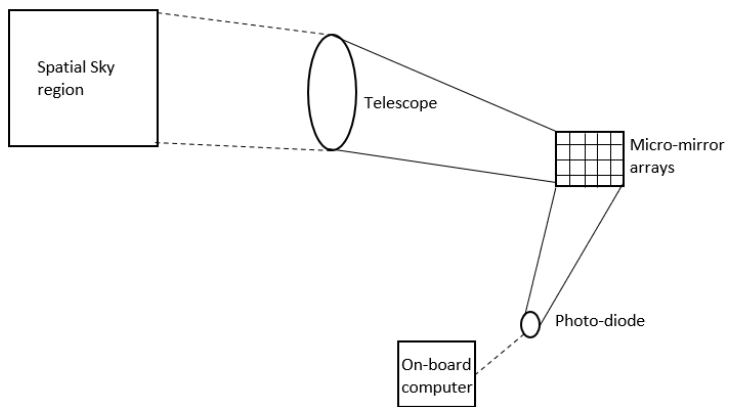
Figure 6. A potential CS implementation of the detector system using a telescope to acquire the light from the spatial region, a set of micro-mirror arrays to reflect light using CS projection methods, and a photodiode to capture a single measurement of the total reflected